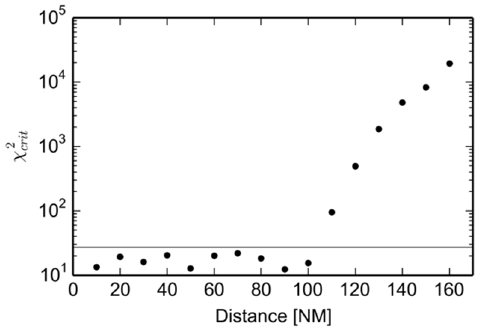
Figure 9. Test statistic χ 2 value of Pearson’s Chi-squared test of goodness of fit for the Weibull distributed vertical track uncertainty VTU. As long as χ 2 < χ 2 crit = 27.58 (grey line) a Weibull distributed VTU can be assumed for distances up to 100 NM. χ 2 crit is derived from the inversion of the Chi-squared distribution density function.